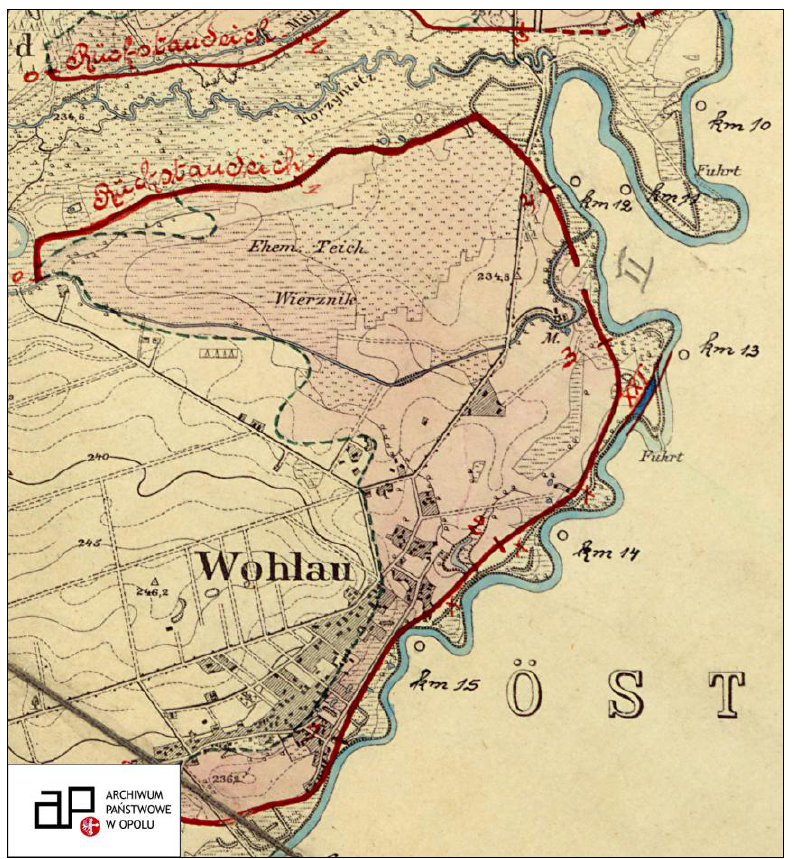
Fig. 7. Hydraulic structures within the River Vistula valley and in the final reach of the River Korzenica in the vicinity of Wola (after Regulierung der…, 1907–1908, original scale: 1:25 000, State Archives in